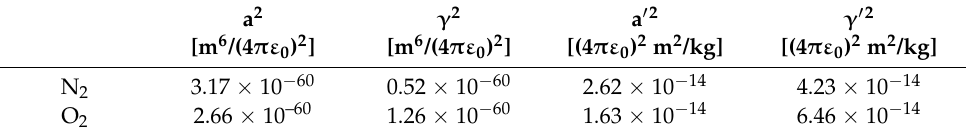
For LiDAR applications, the Raman Backscatter spectrum of N 2 and O 2 is calculated by weighting the DBCS by the atmospheric concentration N , of either N 2 (0.7808) or O